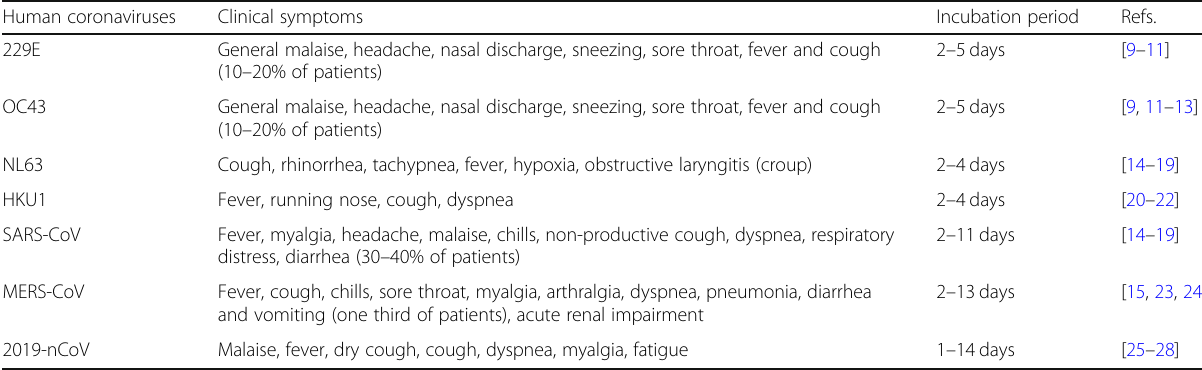
Table 1 Comparison of clinical symptoms and incubation time of human coronaviruses [4] Human coronaviruses Clinical